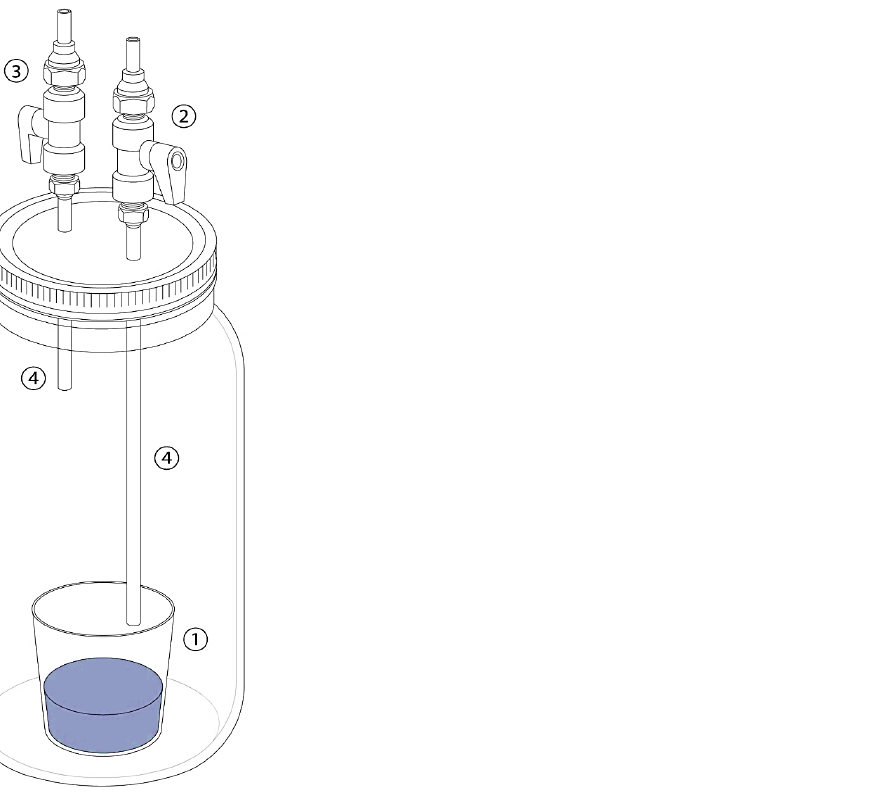
Figure 1. Unit used for incubation with atmospheric sampling by the system of Horgan et al. [38], consisting of a specimen container with soil (1) in a 1.9 L Mason jar equipped with a lid having inlet (2) and outlet (3) ball valves (item # 38EF92, Grainger, Lake Forest, IL, USA) connected to 6.4 mm O.D. brass tubing (4). Analyses for CO 2 and O 2 were performed using a Hewlett-Packard Model 5790A gas